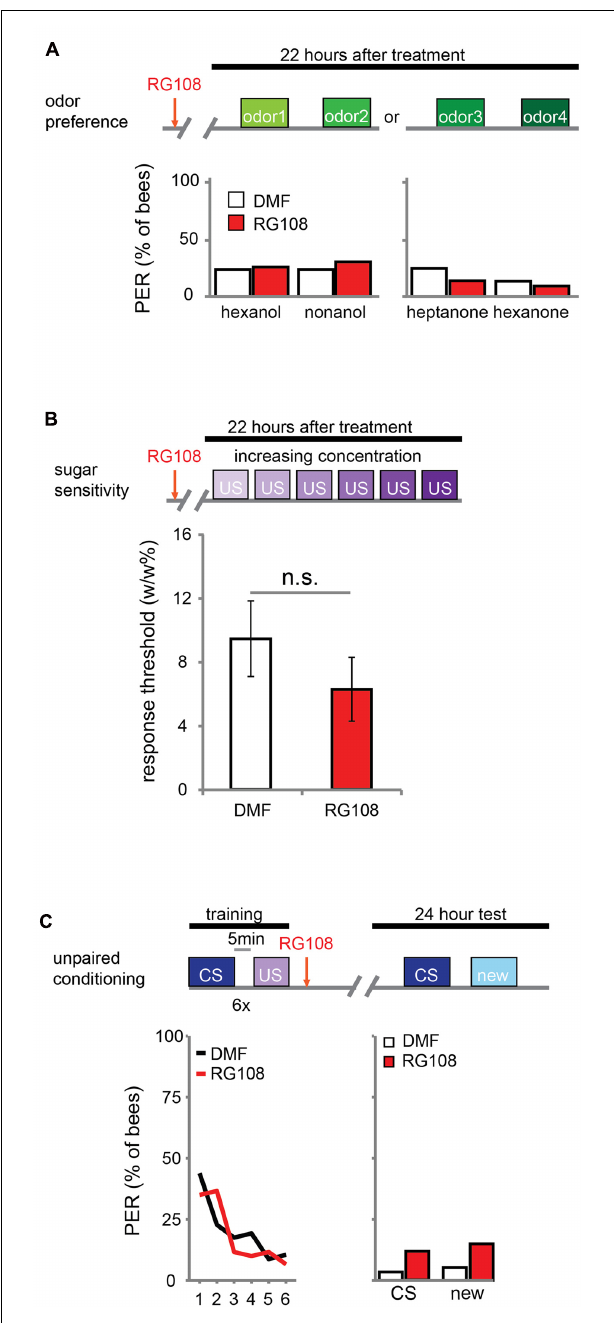
FIGURE 1 | DNA methyltransferases (Dnmts) do not affect odor or sugar perception in the absence of learning. (A) The percentage of bees naïvely responding to all odors used in this study is shown. Bees were treated with 1 µ l of the Dnmt inhibitor RG108 or the solvent DMF 22 h before the test, but no training took place. Two experiments: one with hexanol and nonanol [ n (RG108) = 65, n (DMF) = 58], one with heptanone and hexanone [ n (RG108) = 43, n (DMF) = 44]. Naïve odor responses were not different after RG108 treatment. (B) Bees were tested for their sugar responsiveness 22 h after RG108 treatment. Increasing concentrations of sugar water (0.1–30% w/w) were presented to their antennae. The response threshold is shown (mean + / − SEM). The response threshold was not different between